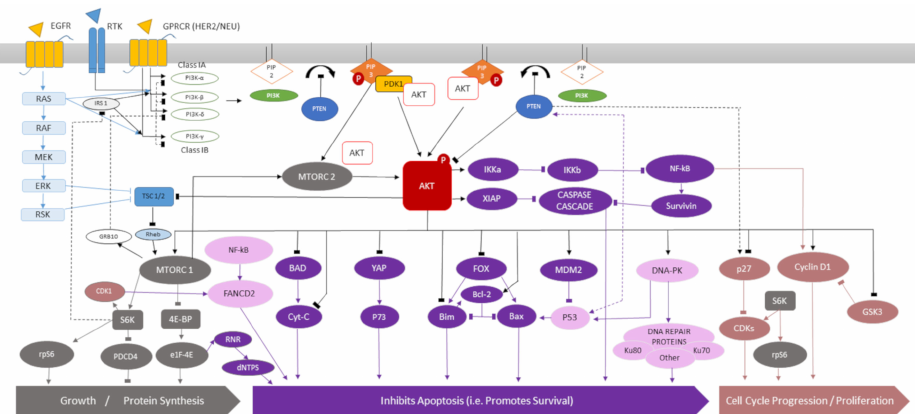
Figure 1. The PI3K / AKT / mTOR pathway activation leads to cell growth, increased protein synthesis, inhibited apoptosis, cell cycle progression and proliferation. For a more detailed description of the pathway components see Figure S1 in the supplementary materials section. Regulatory proteins: Phosphatidylinositol-3-kinase (PI3K)—class IA ( α , β , δ ) or class IB ( γ ), Phosphatidylinositol-4,5-bisphosphate (PIP2), Phosphatidylinositol-3,4,5-bisphosphate (PIP3), 3-phosphoinositide-dependent protein (PDK1), Tuberous sclerosis proteins 1 and 2 (TSC-1 / 2),